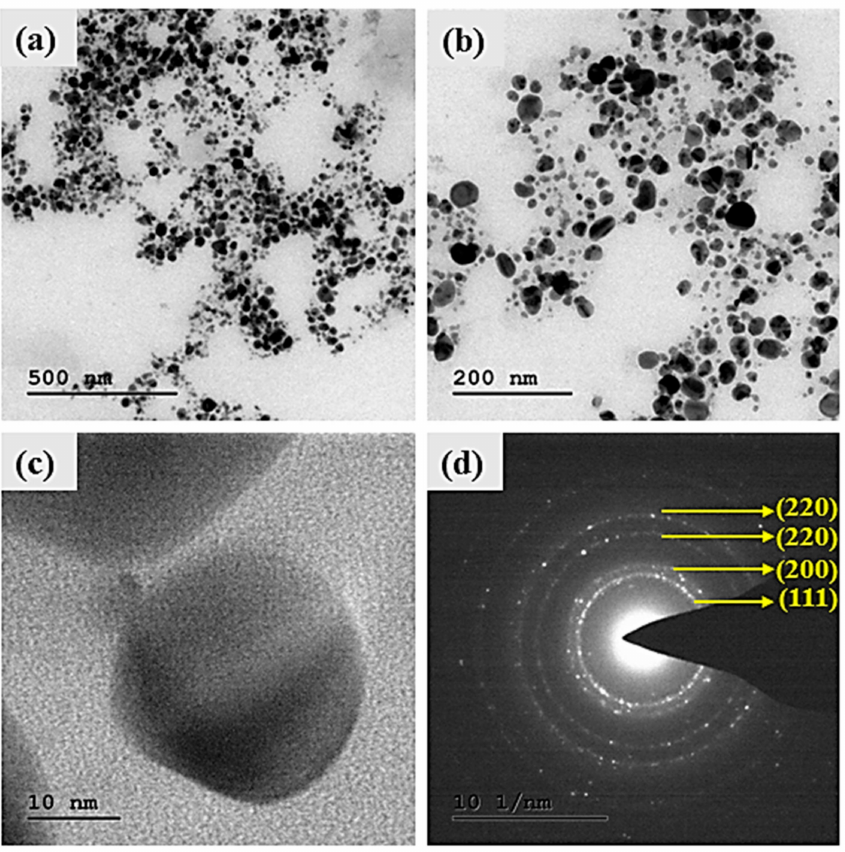
Figure 6. TEM image: ( a ) 500 nm, ( b ) 200 nm, ( c ) 10 nm, and ( d ) selected area di ff raction electron (SAED) patterns of Ag NPs synthesized from S. irio.